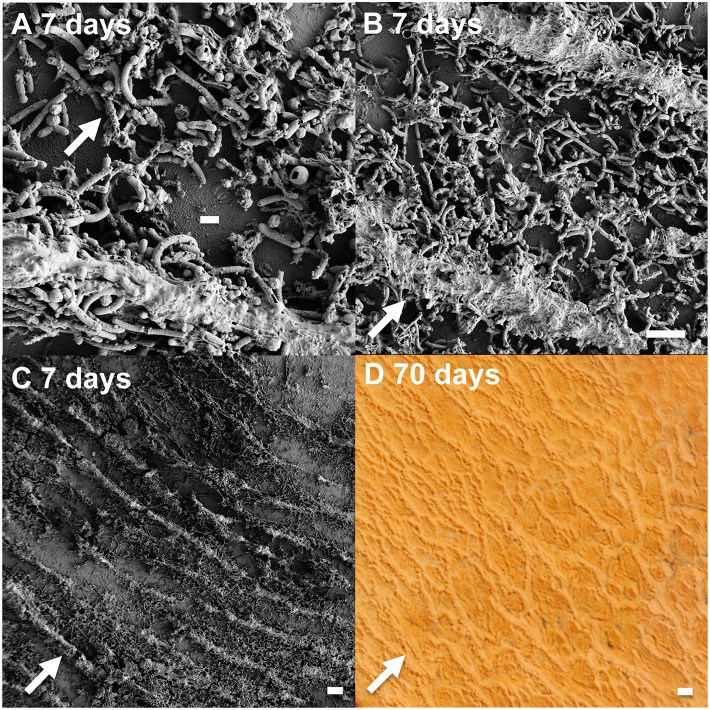
Growth and formation of microterracettes from slides incubated in Beowulf Spring. Scanning electron micrographs (A–C) of ridge structures: scale bar = 1 μm (A), and 10 μm (B,C). Photograph of larger, 1 mm ridges (D) present in 70 days Fe(III)-oxide mats incubated for 70 days (scale bar = 1 mm). The flow direction (arrows) is perpendicular to microterracettes.